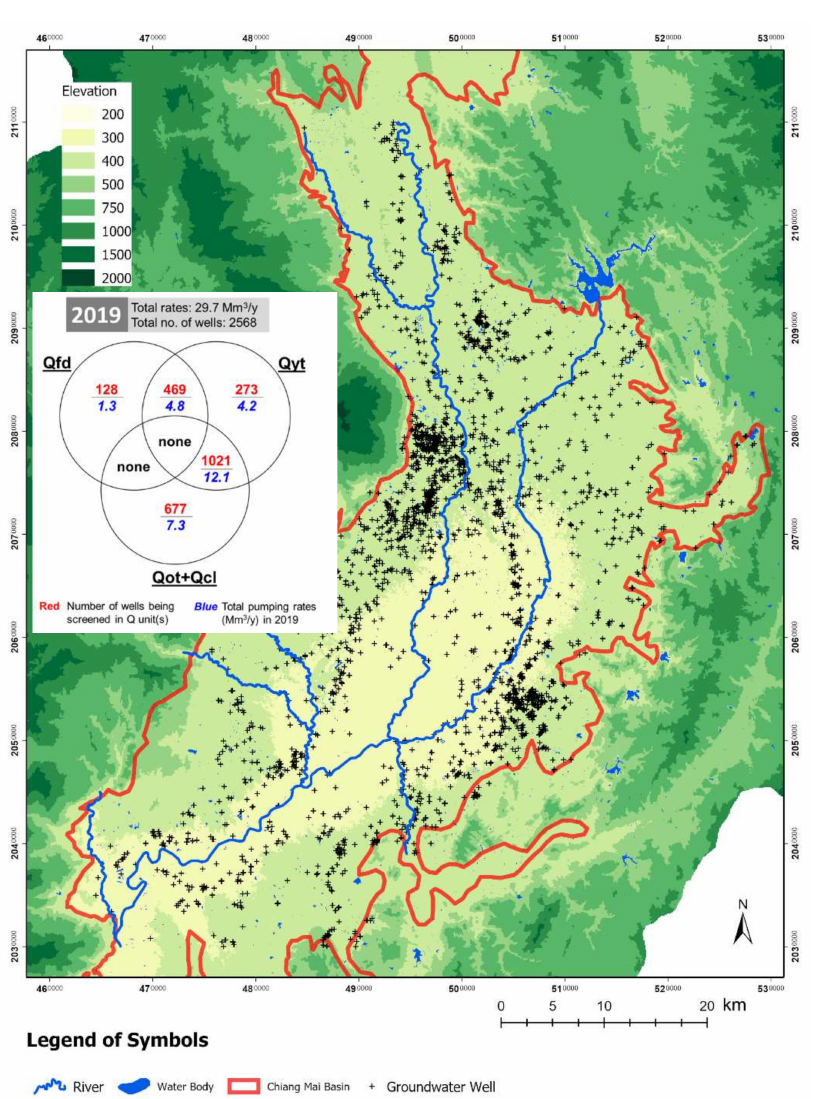
Figure 6. Locations of groundwater extraction wells in Qfd, Qyt, and Qot + Qcl units and their extraction